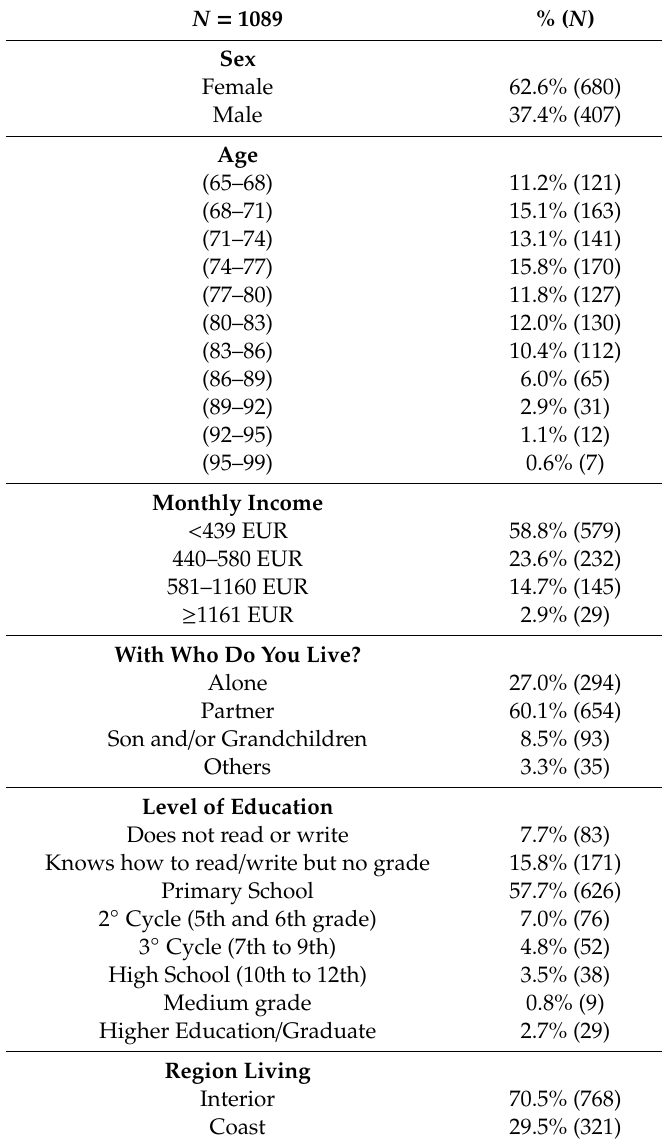
Table 1. Socio-demographic characteristics of the